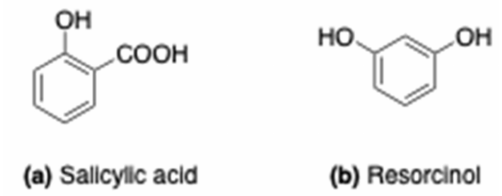
Figure 3. Chemical structure of ( a ) salicylic acid and ( b )